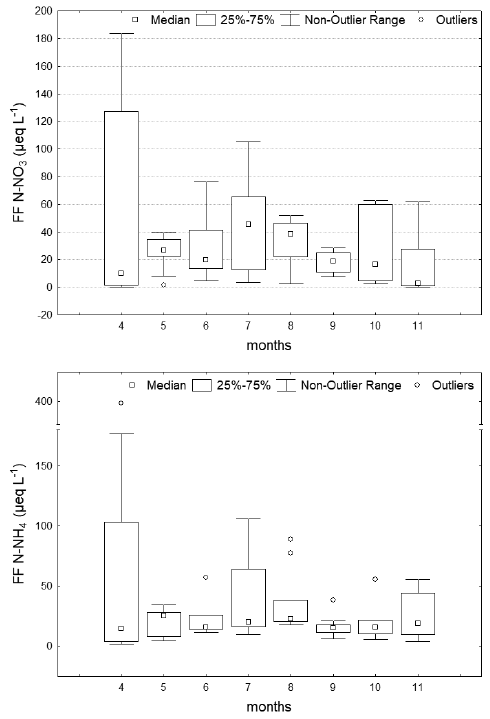
Figure 5. Box & Wisker showing the monthly variations of NO floor leachates